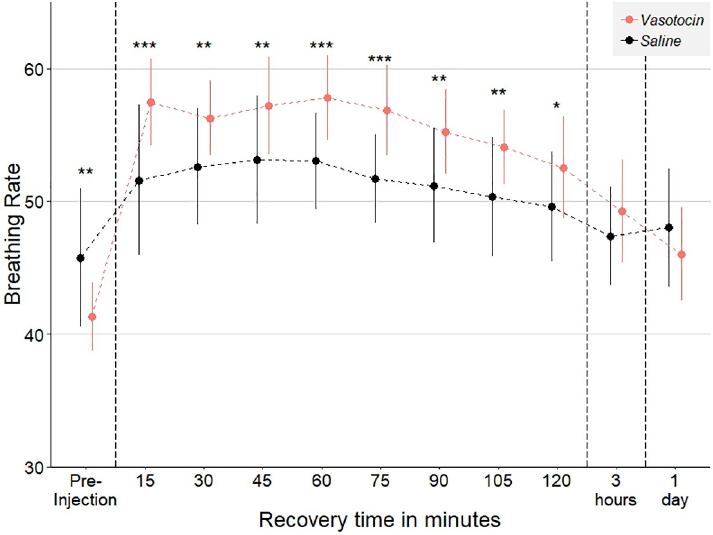
Fig 7. Differences in respiration rate following injection between brain injection of exogenous vasotocin ( N = 15) and saline injected controls ( N = 39). Fish injected with vasotocin had an elevated respiration rate compared to saline injected controls for more than two hours following injection. Mean ± SE � p � 0.05; �� p � 0.01; ��� p � 0.001.